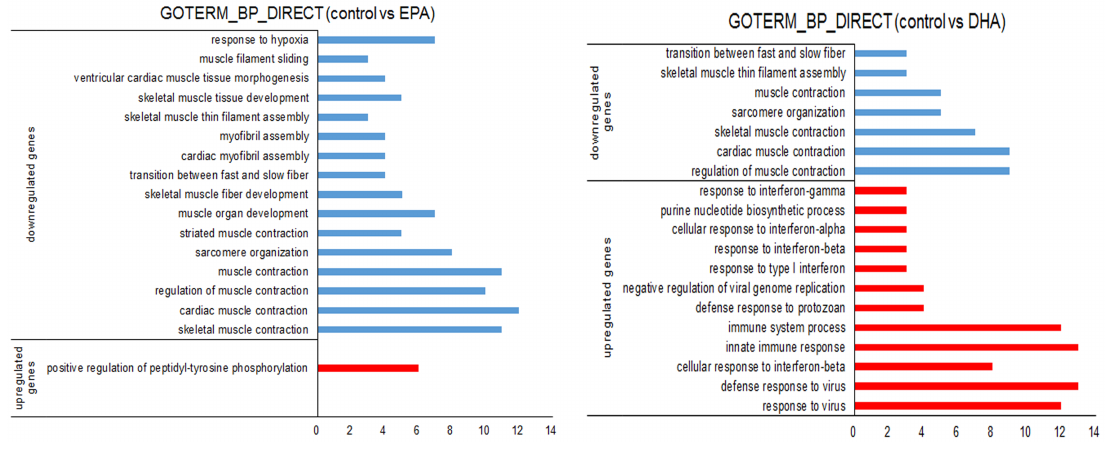
Figure 4. The enriched Gene Ontology (GO) terms of the biological process (BP) form the differentially expressed genes (DEGs) in EPA treatment and DHA treatment. The X axis represents the number of DEGs. The Y axis represents GO